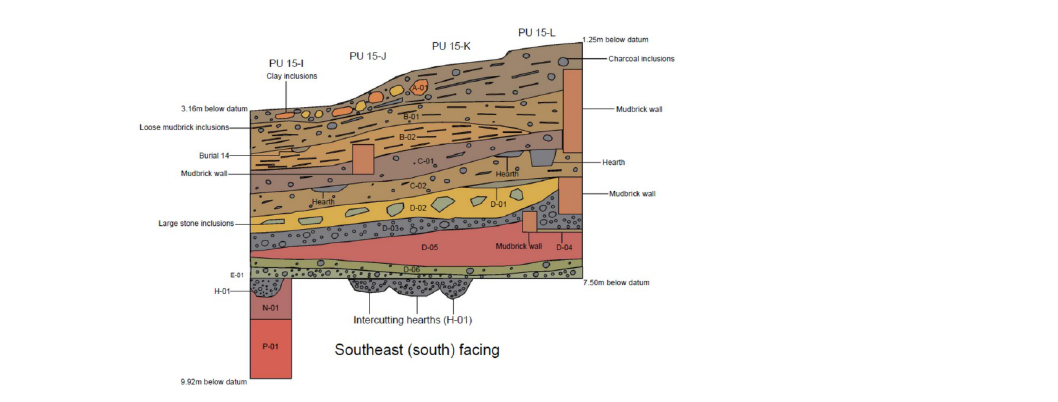
Fig 5. Stratigraphic profile of the West Trench, Ganj